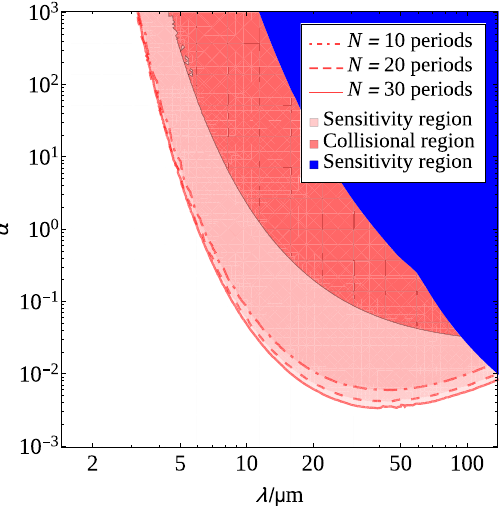
(cid:11) T max , defined in Eq. (22), to be as large as 2 s (twice the assumed BN clock precision), for N rev = 10 (dot-dashed lines), N rev = 20 (dashed lines), and N rev = 30 revolutions (solid lines). Left panel: the initial conditions are chosen so that the trajectory of S around P starts at the apoapsis: r 0 = r apo = 150 μ m and ˙ θ 0 = 273 . 0 μ rad s − 1 ; Right panel: the initial conditions are chosen so that the trajectory of S around P starts at a point between the periapsis and the apoapsis, by choosing a non-vanishing initial radial velocity: r 0 = 111 . 8 μ m, ˙ r 0 = 30 . 6 nm s − 1 and ˙ θ 0 = 491 . 4 μ rad s −